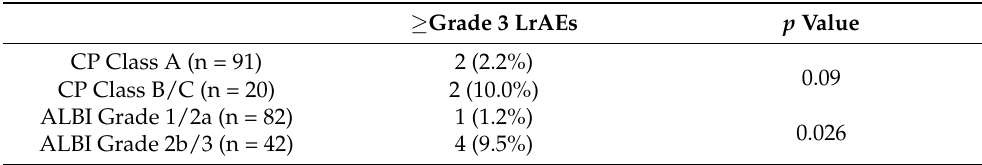
Table 5. The number of severe LrAEs in patients with cirrhosis.